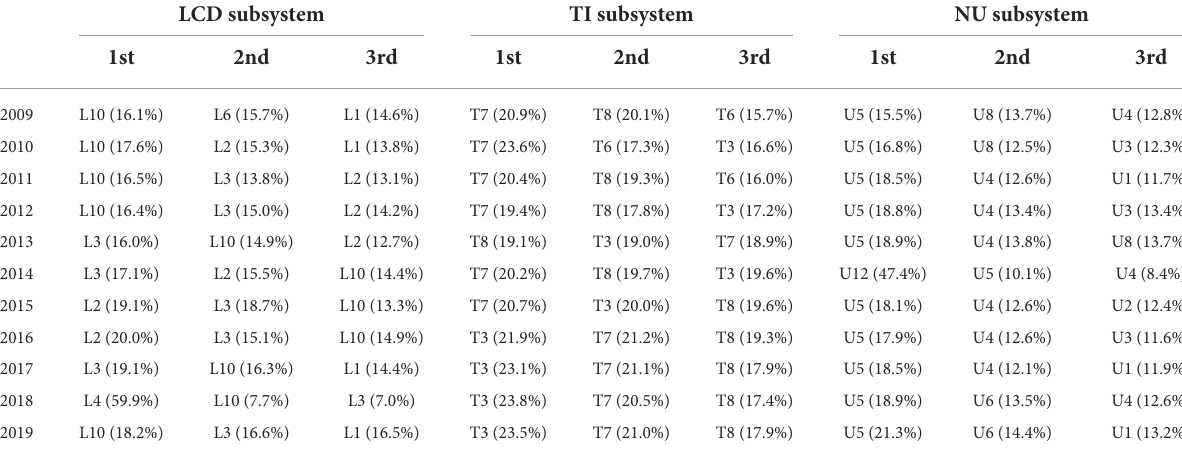
TABLE 7 Obstacle indexes of each subsystem,